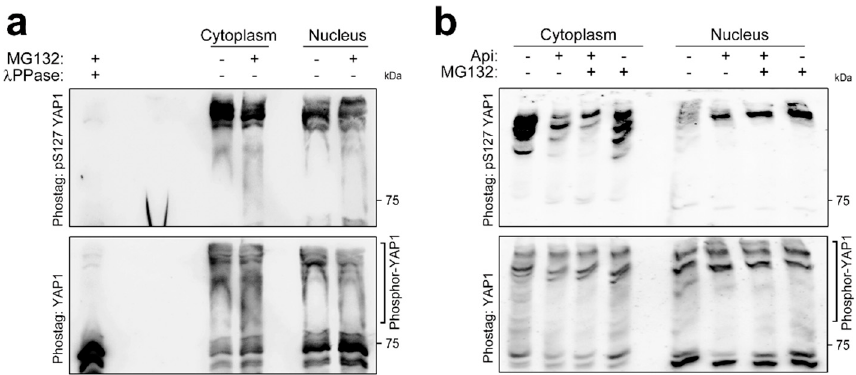
Figure 2. Serine 127 phosphorylation fails to restrict YAP1 in the cytoplasm. ( a ) Phosphor-S127 YAP1 localized both in the cytoplasm and in the nucleus in hTERT-MSCs. Phos-tag phosphoprotein gel stain greatly exaggerated retardation of phosphorylated proteins in the SDS-PAGE. Proteins were separated by various grades of phosphorylation (bottom). Phosphor-specific antisera against S127 phosphor-YAP1 successfully probed nuclear YAP1 accumulated by MG132 treatment. The specificity of phosphor-S127 antibody was confirmed by the first lane, which was incubated with lambda phosphatase; phosphor-S127 antibodies did not detect anything (top). ( b ) Apicidin forced nuclear localization of YAP1 in the presence of S127 phosphorylation. Phosphor-S127 YAP1 antibody visualized nuclear YAP1. Abbreviations: Api, apicidin; λ PPase, lambda phosphatase.